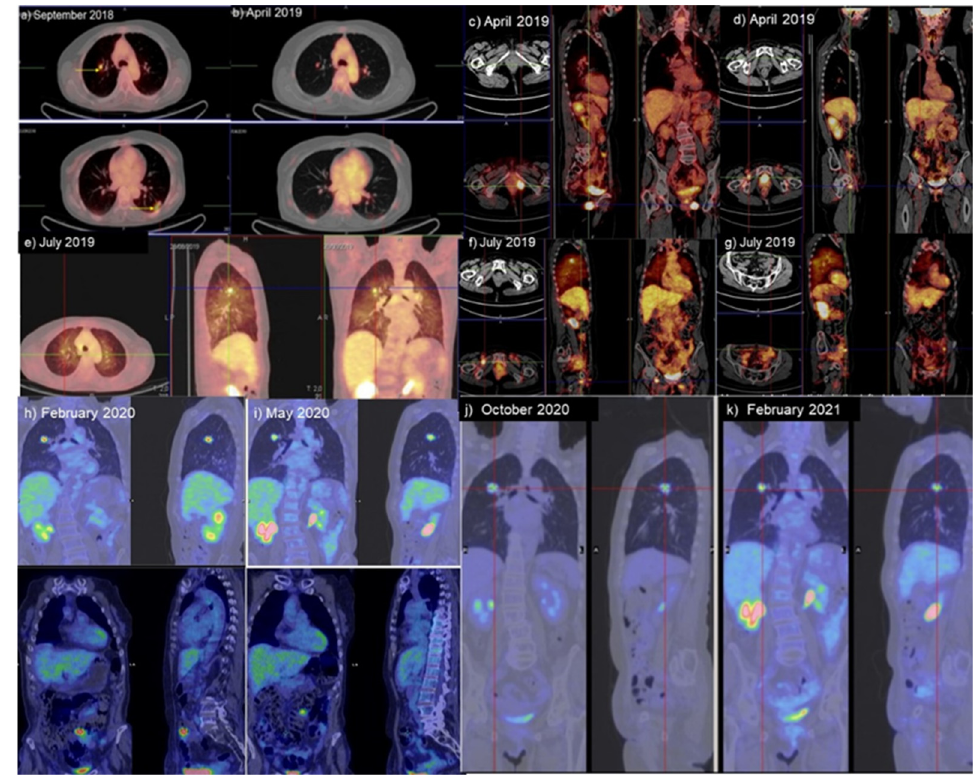
Figure 2. PET/CT during disease course: ( a ) In September 2018, PET/CT showed the appearance of hypermetabolic bilateral lung nodules; ( b ) the PET/CT scans of April 2019 after 6 months of Nivolumab showed a significant reduction in and disappearance of hypermetabolic activity of the lung lesions; ( c , d ) PET/CT scan on April 2019 showed stable hypermetabolic activity in the left perineum and vagina and hypermetabolic activity in the right inguinal region; ( e – g ) in July 2019, imaging showed progression of disease in the lung ( e ) in comparison to April 2019, as well as the appearance of hypermetabolic areas in the left anterior abdominal wall ( f ) and in the right inguinal region ( g ); ( h , i ) PET/CT imaging on February ( h ) and May 2020 ( i ) after 6 and 9 months of treatment with mTOR inhibitor, respectively; ( j , k ) PET/CT imaging in October 2021 and February 2021 before and after 3 months of treatment with